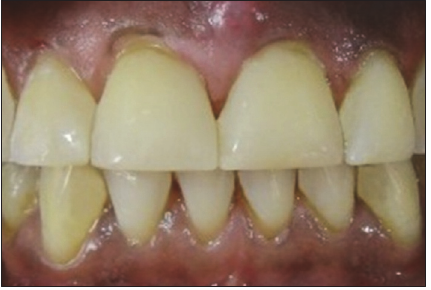
Figure 12: View of the restorations at 14-month